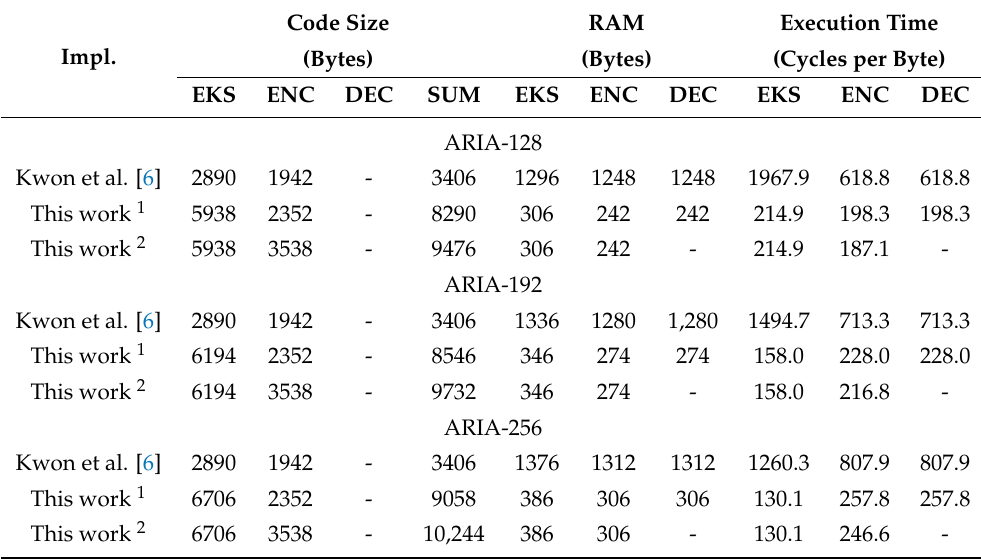
Table 4. Comparison results of ARIA block ciphers on 8-bit AVR microcontrollers in terms of code